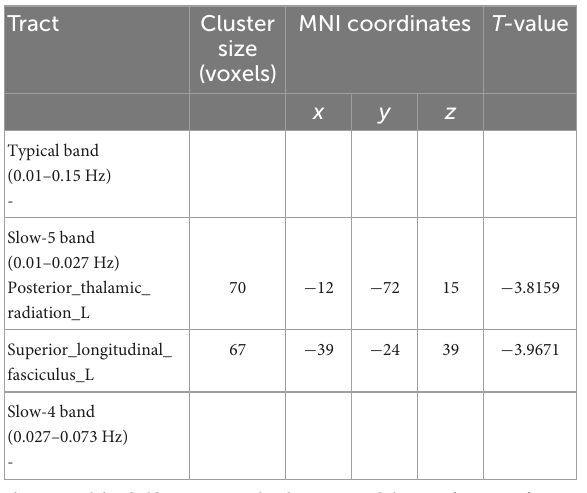
TABLE 2 Results of two-sample t -test from amplitude of low frequency fluctuation (ALFF) analysis comparing major depressive disorder (MDD) and healthy controls